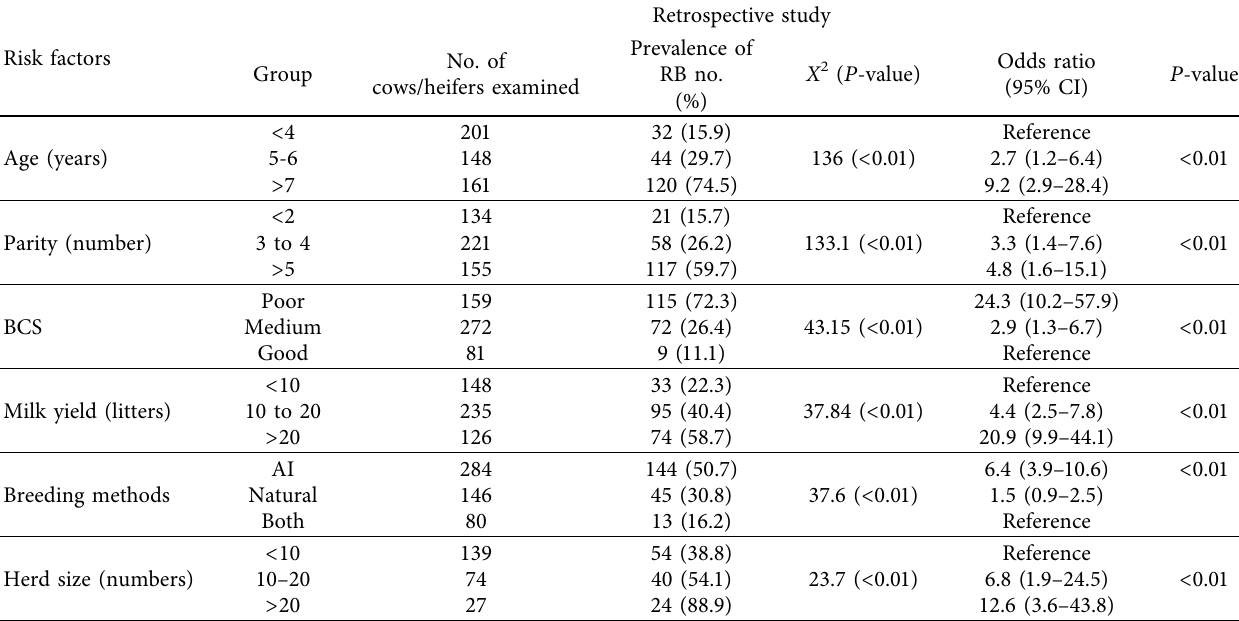
Table 2: Repeat breeders with risk factors (age, parity, BCS, milk yield, breeding methods, and herd size) in crossbred dairy